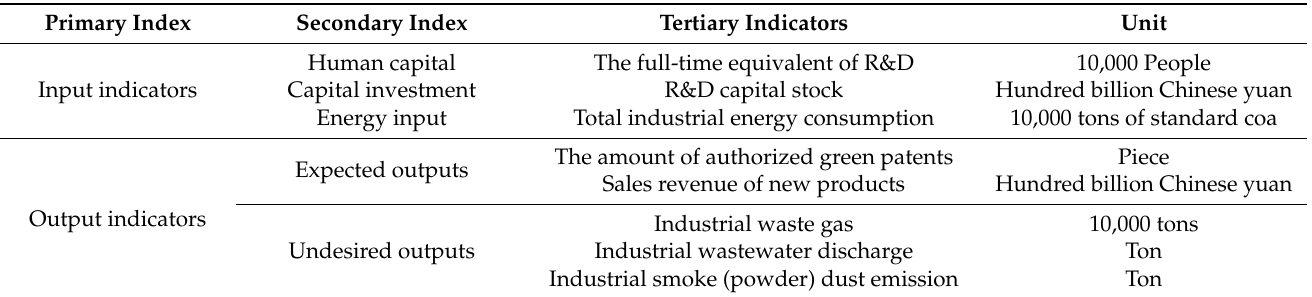
Table 1. Green innovation efficiency index